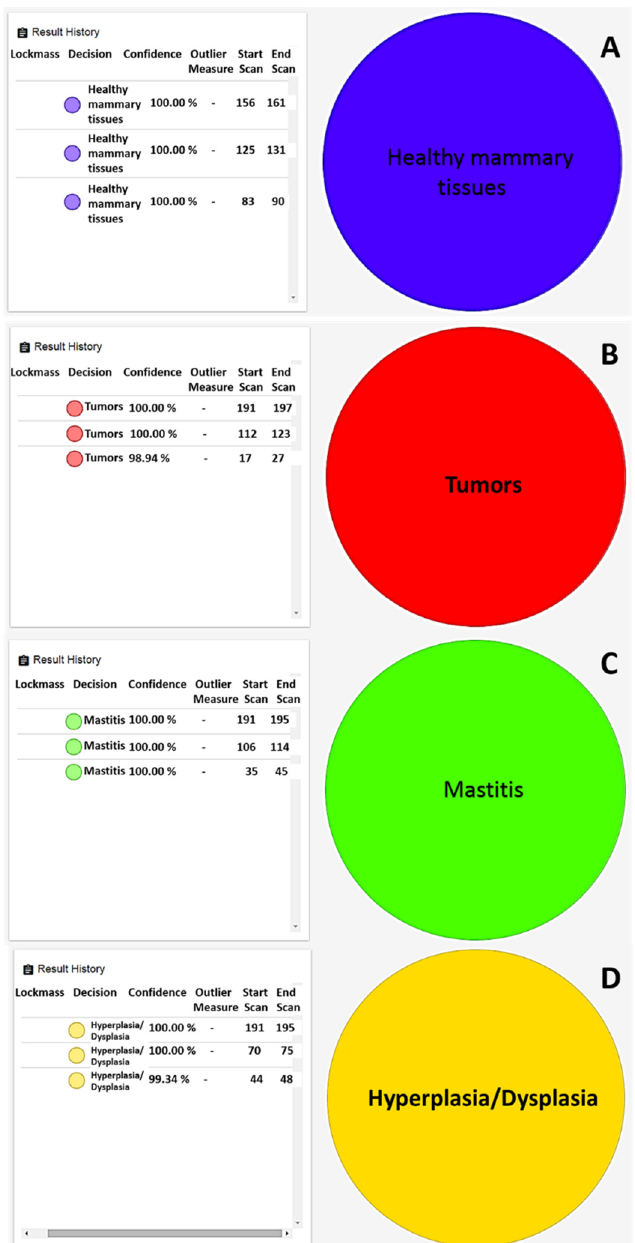
Figure 3. Real-time identification of ( A ) healthy mammary gland, ( B ) comedocarcinoma as malignant tumor, ( C ) margin tissue of comedocarcinoma, ( D ) ductal ectasia .